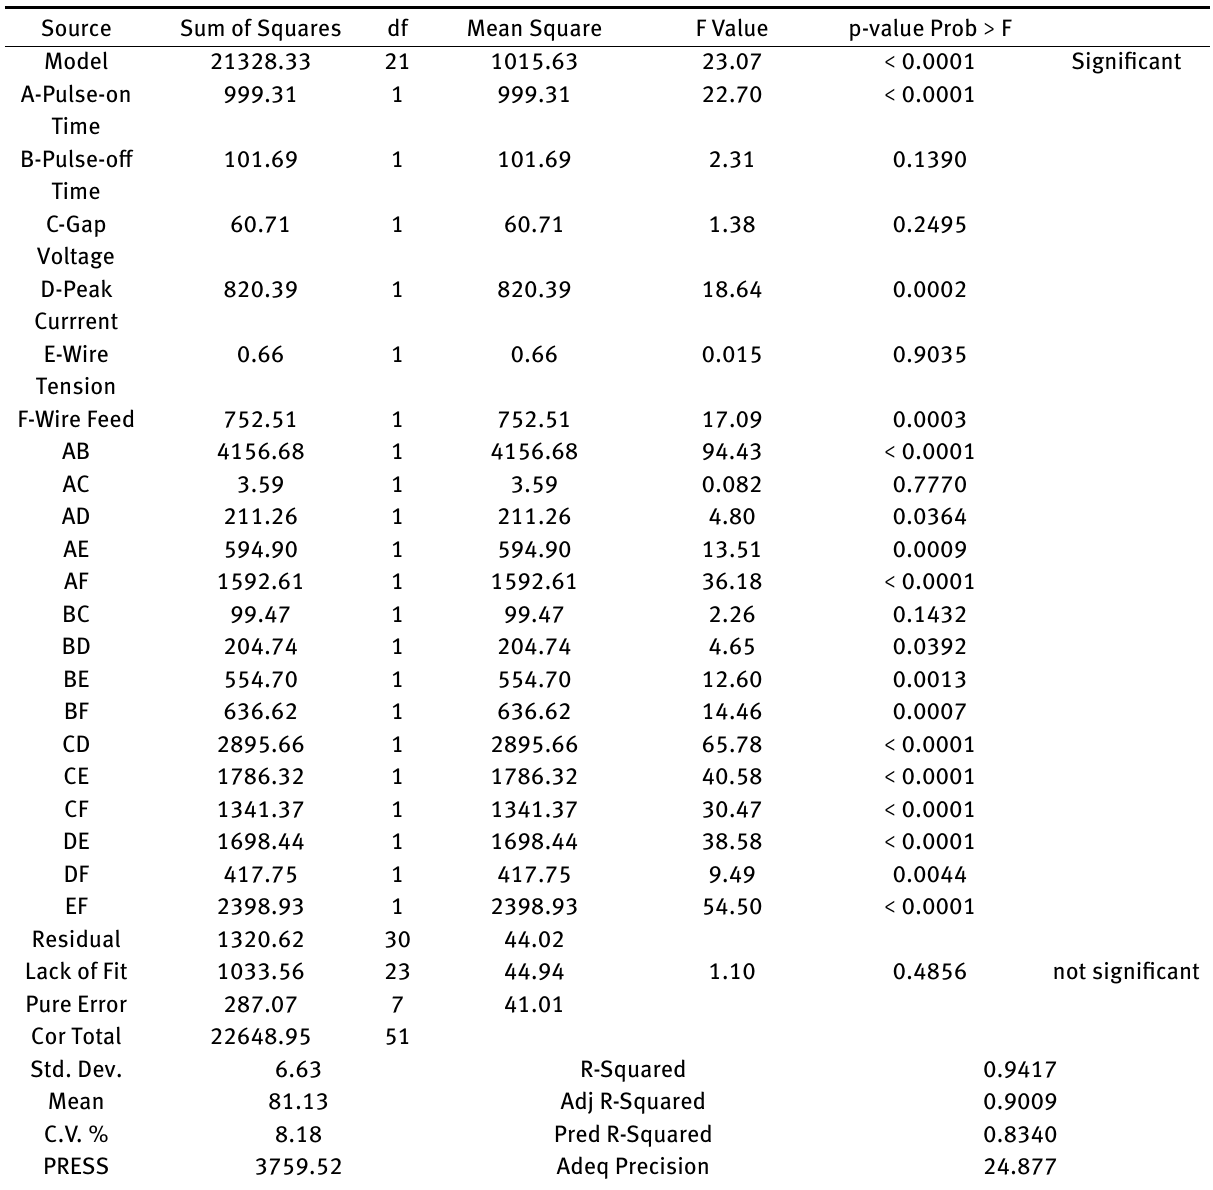
Table 6: Analysis of variance (ANOVA) for response surface WWR